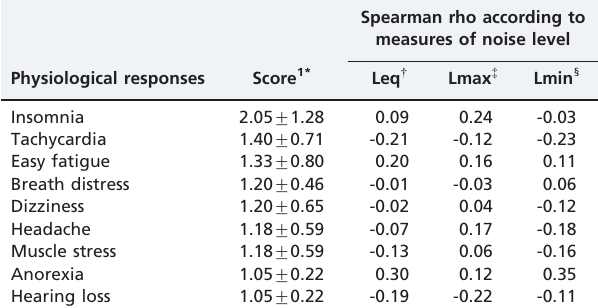
Table 3 - Scores of physiological responses and their correlations with noise level, indicated by Spearman correlation coefficients (n= 40).